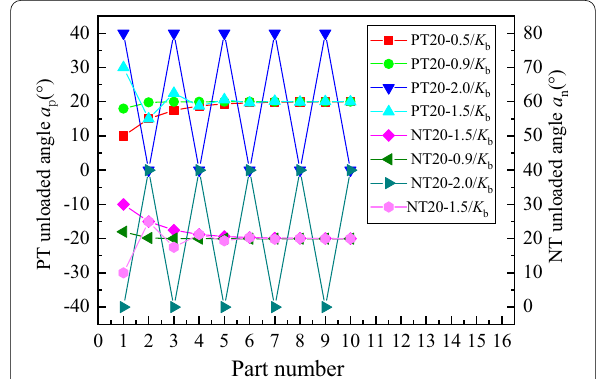
Figure 10 Curves of bending angle after springback